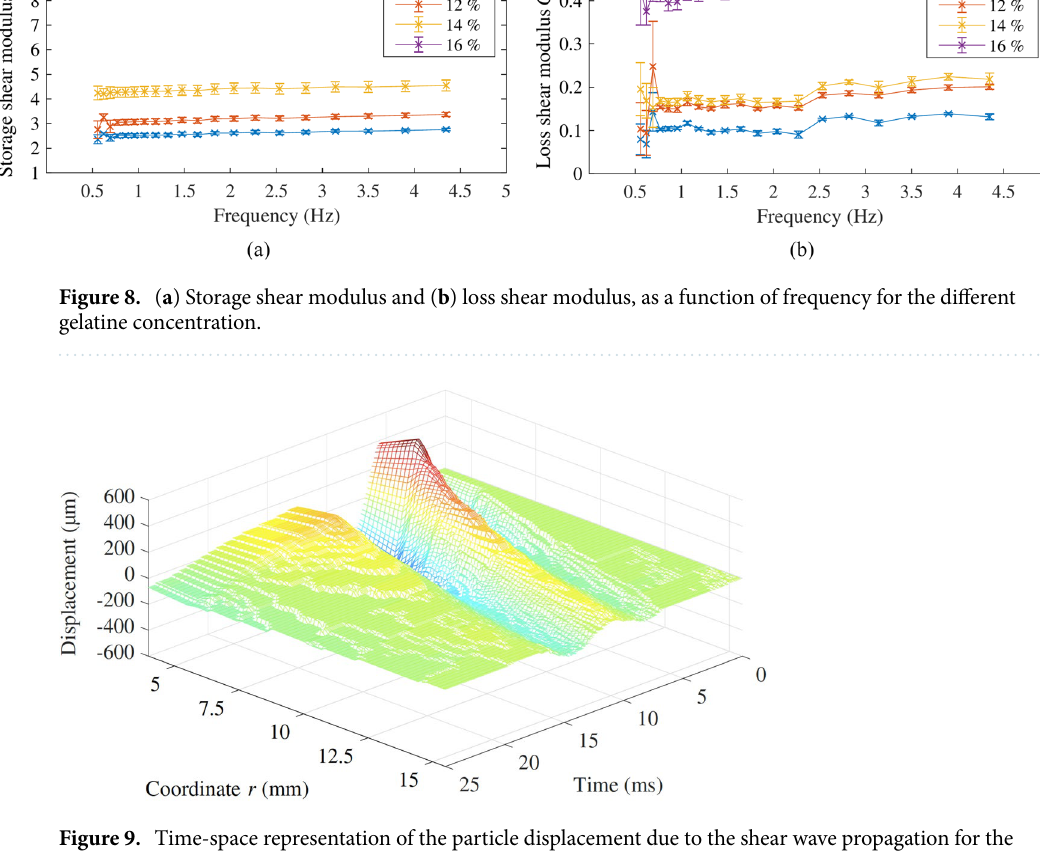
Figure 9. Time-space representation of the particle displacement due to the shear wave propagation for the illustrative case in plane A. The propagation of the shear wave was recorded for 25 ms. The r coordinate ranged from 4 to 15.5 mm, with r = 0 corresponding to the centre of the disk emitter, and the inclusion front face at approximately r = 15 mm. Although the driving signal was a single sinusoidal cycle, the displacement of the emitter (visible at r = 4–5.5 mm) showed a noticeable extension due to the inertia of the